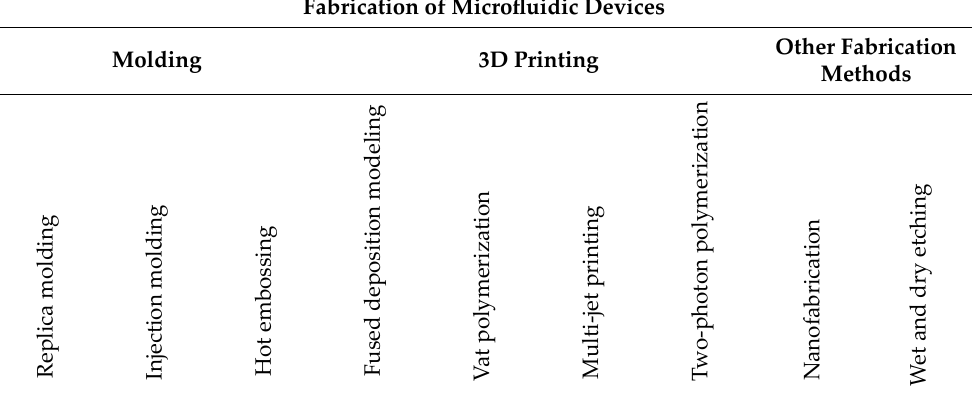
Table 2. An outline of microfluidic fabrication